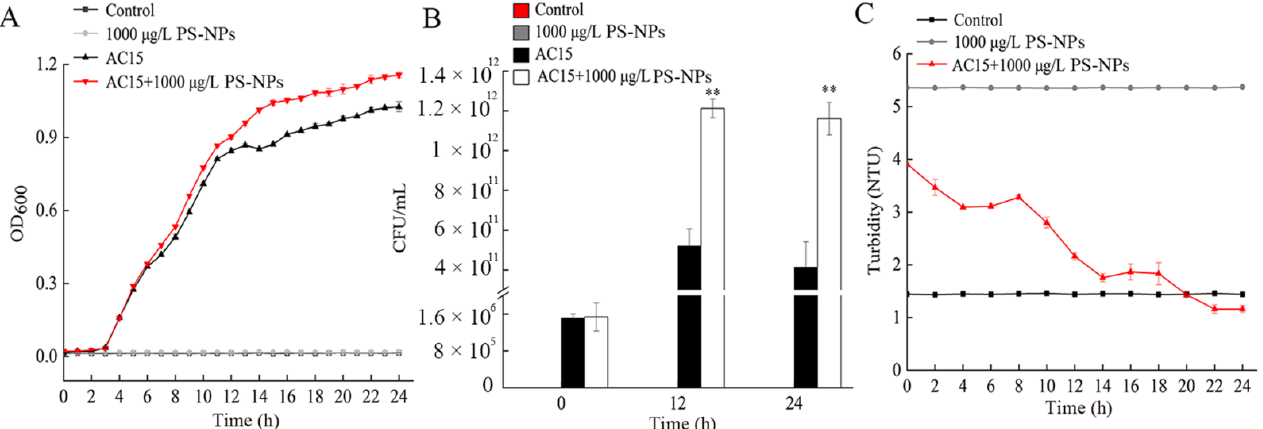
Figure 4. Adsorption curve of nanopolystyrene particles (NPs) during bacterial growth. ( A ) A. johnsonii AC15 growth curve after exposure to 1000 μg/L NP. ( B ) Effect of 1000 μg/L NP exposure on colony-forming unit (CFU) of A. johnsonii AC15 at different times. ** p < 0.01 vs. A. johnsonii AC15. ( C ) Turbidity analysis of bacterial solutions after cultivation at 37 °C for 24 h.